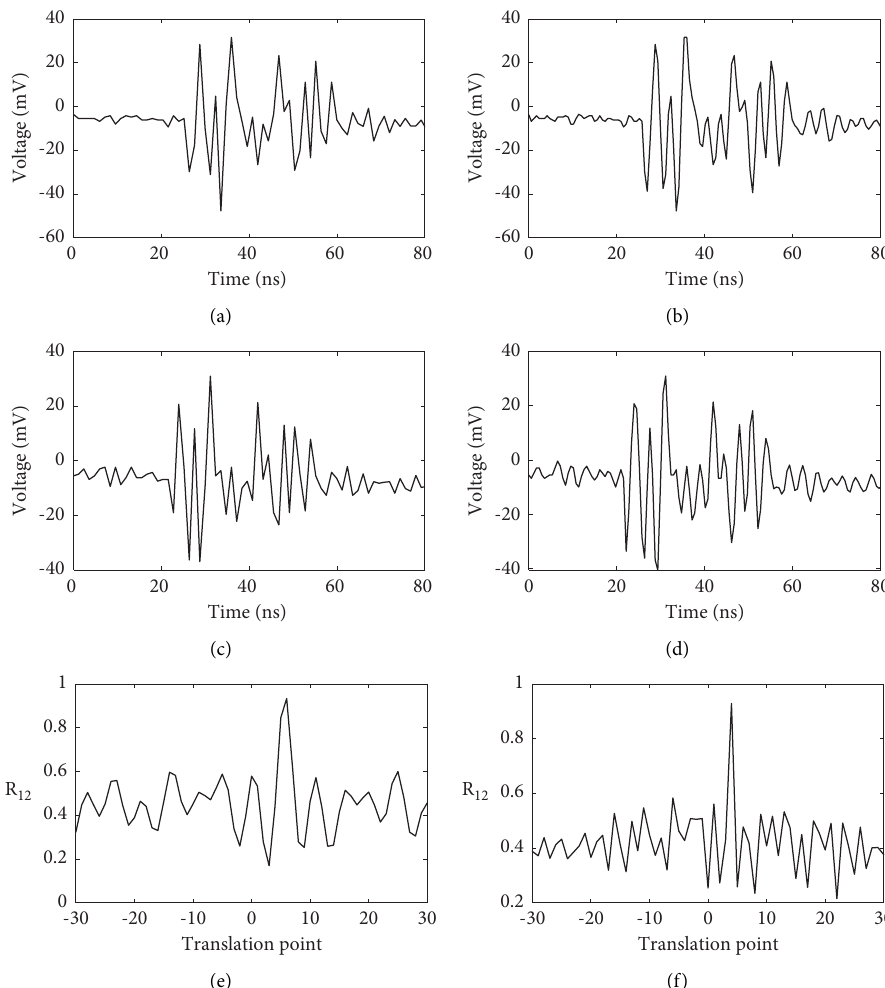
Figure 6: The verification experiment results. (a) Antenna A received PD UHF signals. (b) Interpolated antenna A received PD signal by fuzzy interpolation. (c) Antenna B received PD UHF signals. (d) Interpolated antenna A received PD signal by fuzzy interpolation. (e) Correlation coefficient curve for received signals. (f) Correlation coefficient curve for interpolated signals by fuzzy interpolation.